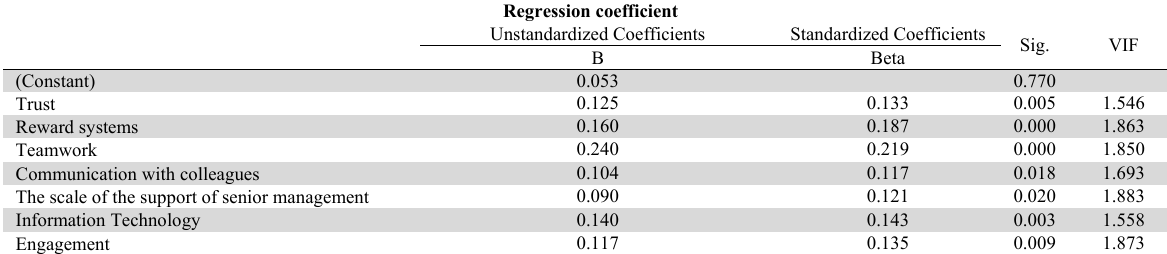
Regression model of factors affecting knowledge sharing